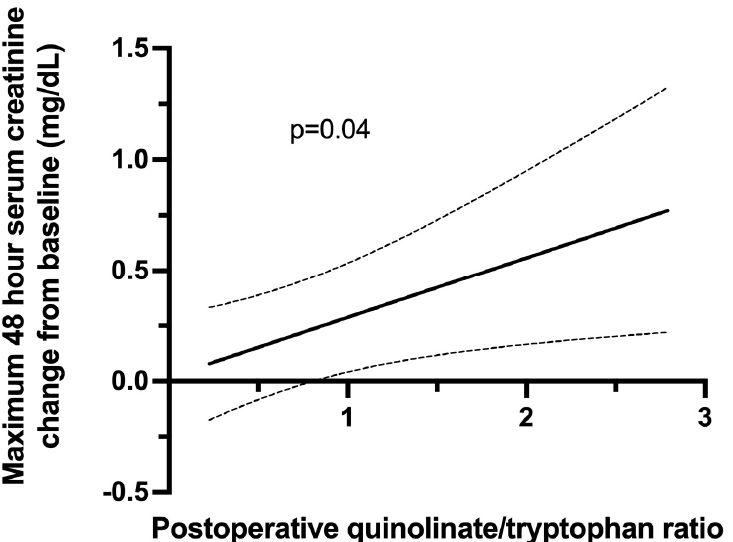
Figure 4. Postoperative urinary quinolinate/tryptophan ratio and maximum change in serum creatinine from baseline postoperatively. Do tt ed lines denote the 95% con fi dence interval.